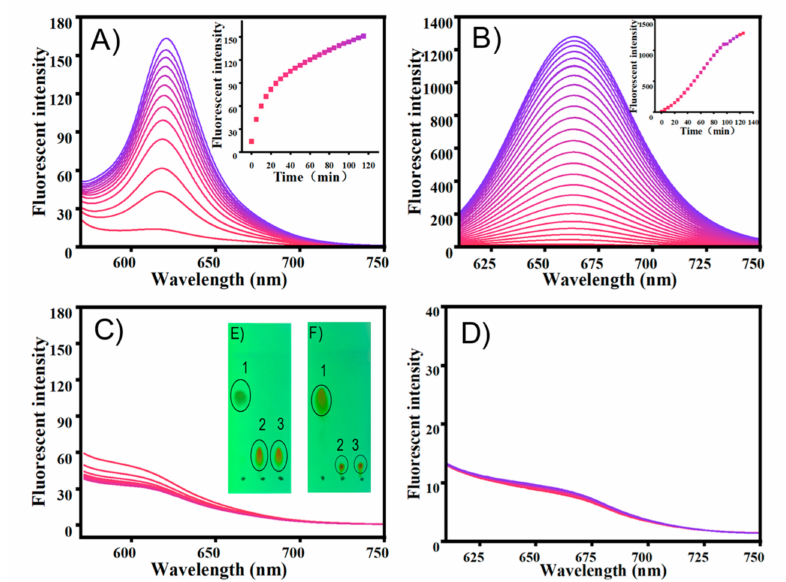
Figure 1. The emission changes of probe ( A ) TCF-ester, λ ex = 580 nm, ( B ) DCI-ester, λ ex = 560 nm, ( C ) TCF-ether and ( D ) DCI-ether with BSA (23 mg/mL) in PBS buffer (10 mM, pH 7.4, containing 30% DMSO, v/v ) at 37 ◦ C for 2 h. ( E ) Sample spotted in the TLC plates: 1. DCI, 2. DCI + BSA, 3. DCI-OH. ( F ) Sample spotted in the TLC plates: 1. TCF-ester, 2. TCF-ester + BSA, 3. TCF-OH. Color changes (0–2 h), from pink to